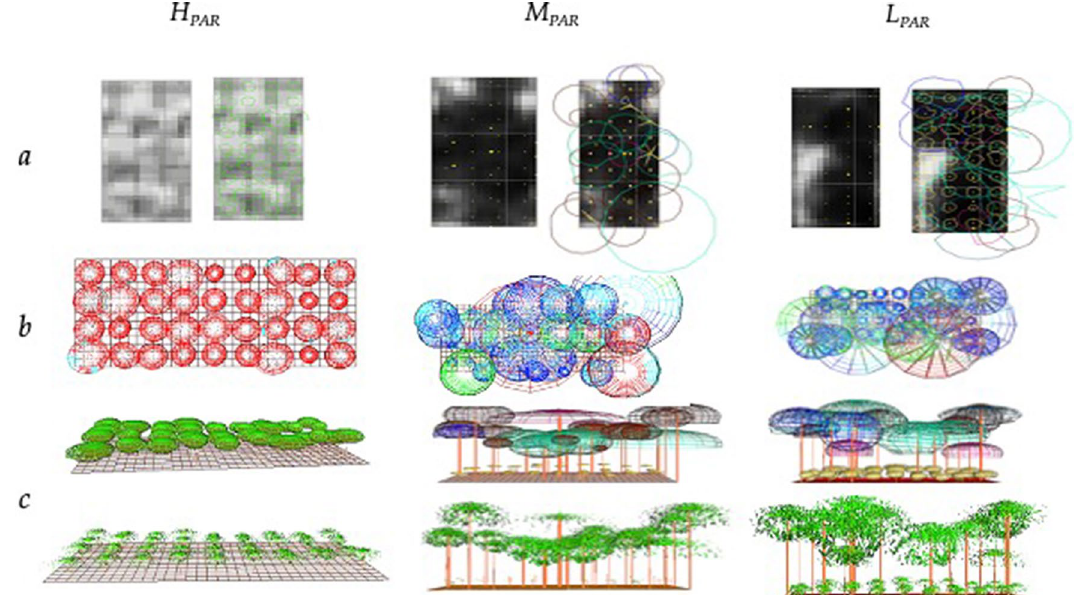
Figure 2. Digital models of the horizontal and vertical structure of each type of agroforestry system (AF) studied. The grayscale in ( a ) corresponds to the level of shadow generated by the shade canopy (darker corresponds to less incident radiation); upper or horizontal ( b ) and lateral or vertical ( c ) profiles of the agroforestry systems with each of the companion species defined with different colors. Digital models were built with SExI-FS 40 and Shademotion 41 software’s. The agroforestry arrangements are: cacao AF with dense Musaceae plantation and high mean diurnal incident radiation (H PAR ); cacao AF with low density of clustered vegetation and medium mean diurnal incident radiation (M PAR ); and cacao AF with high density diversified multistrata vegetation and low mean diurnal incident radiation (L PAR ). Other characteristics of the AFs are described in methods and Table